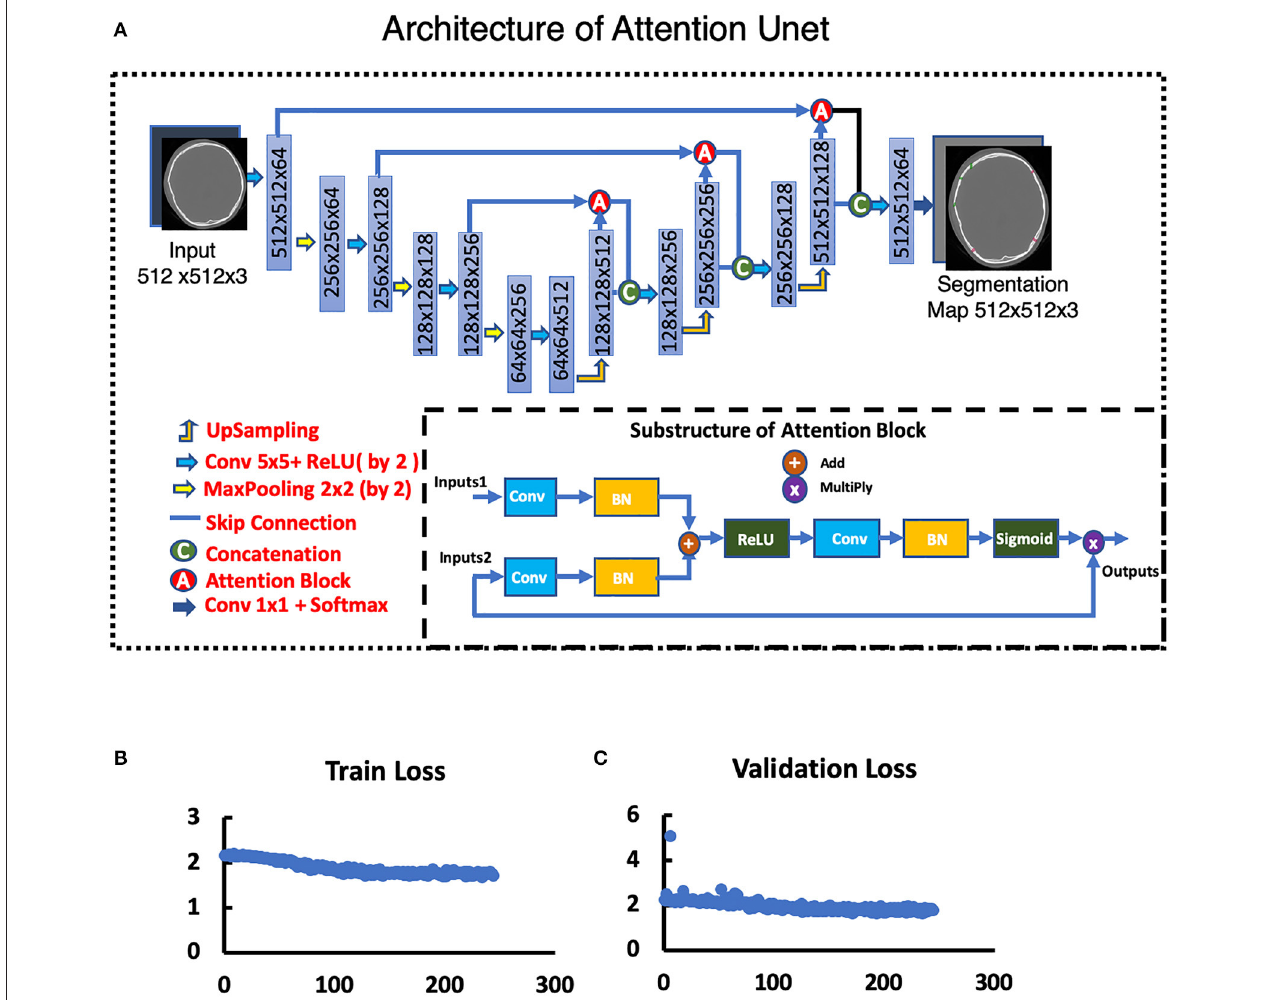
FIGURE 5 | Attention Unet. (A) Architecture of Attention Unet. (B) Train loss curve of Attention Unet. (C) Validation loss curve of Attention Unet.